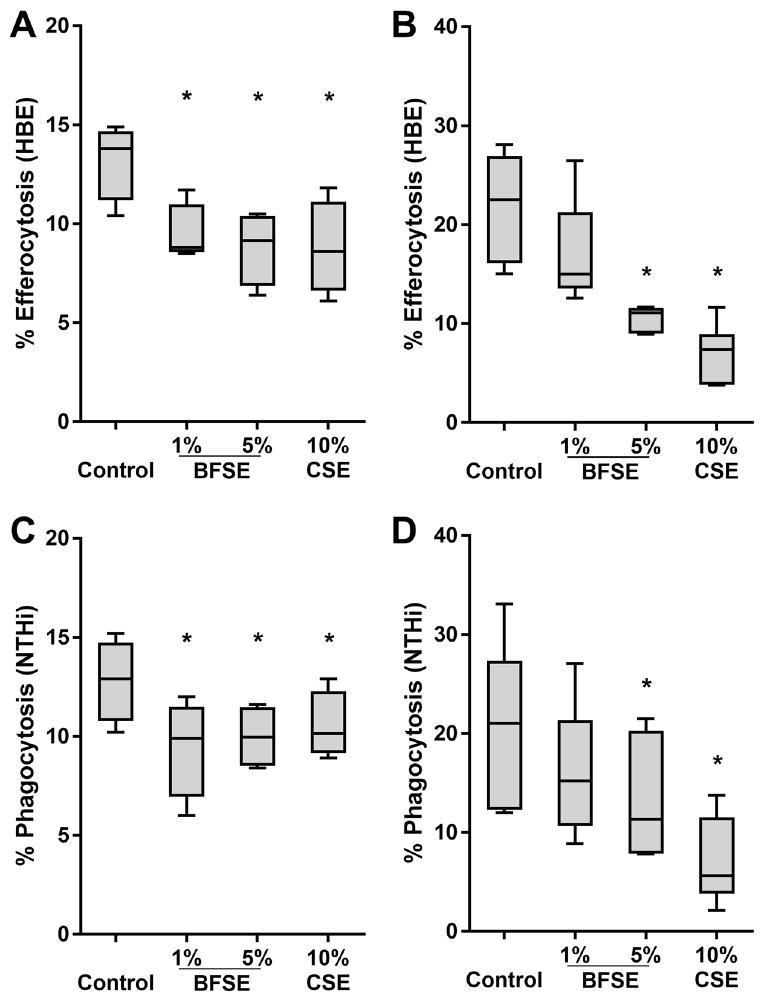
Figure 1. BFSE suppressed macrophage phagocytic capacity. THP-1 macrophage and MDM cells exposed to air control, 1% or 5% BFSE, or 10% CSE for 24 h were cultured with apoptotic epithelial cells and NTHi. Efferocytosis of apoptotic epithelial cells by THP-1 macrophage ( A ) and MDM ( B ) and phagocytosis of NTHi by THP-1 macrophage ( C ) and MDM ( D ) were assessed by flow cytometry and measured as the percentage